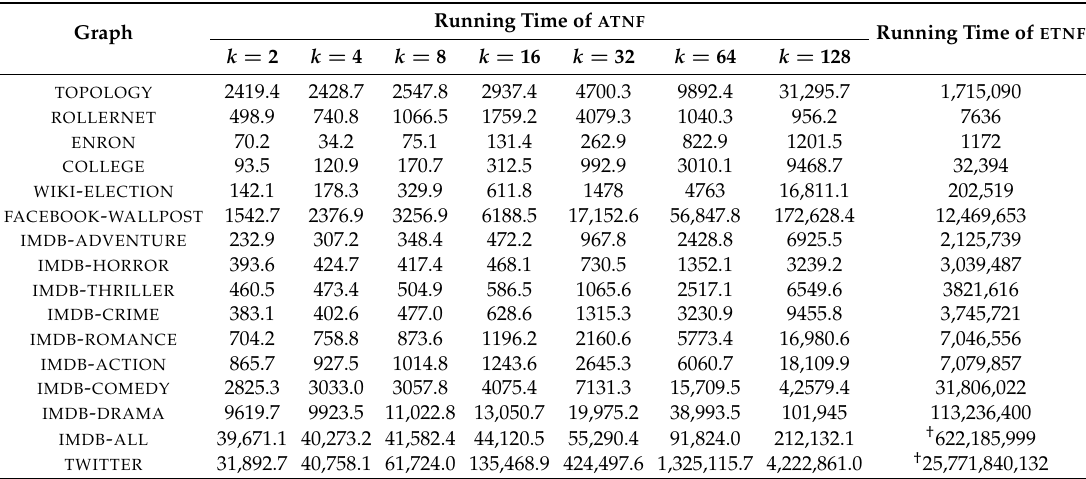
Table 4. Running times (milliseconds) of ATNF for different values of k compared with the running time of ETNF . The numbers marked with † are estimated due to the computation limits of ETNF .